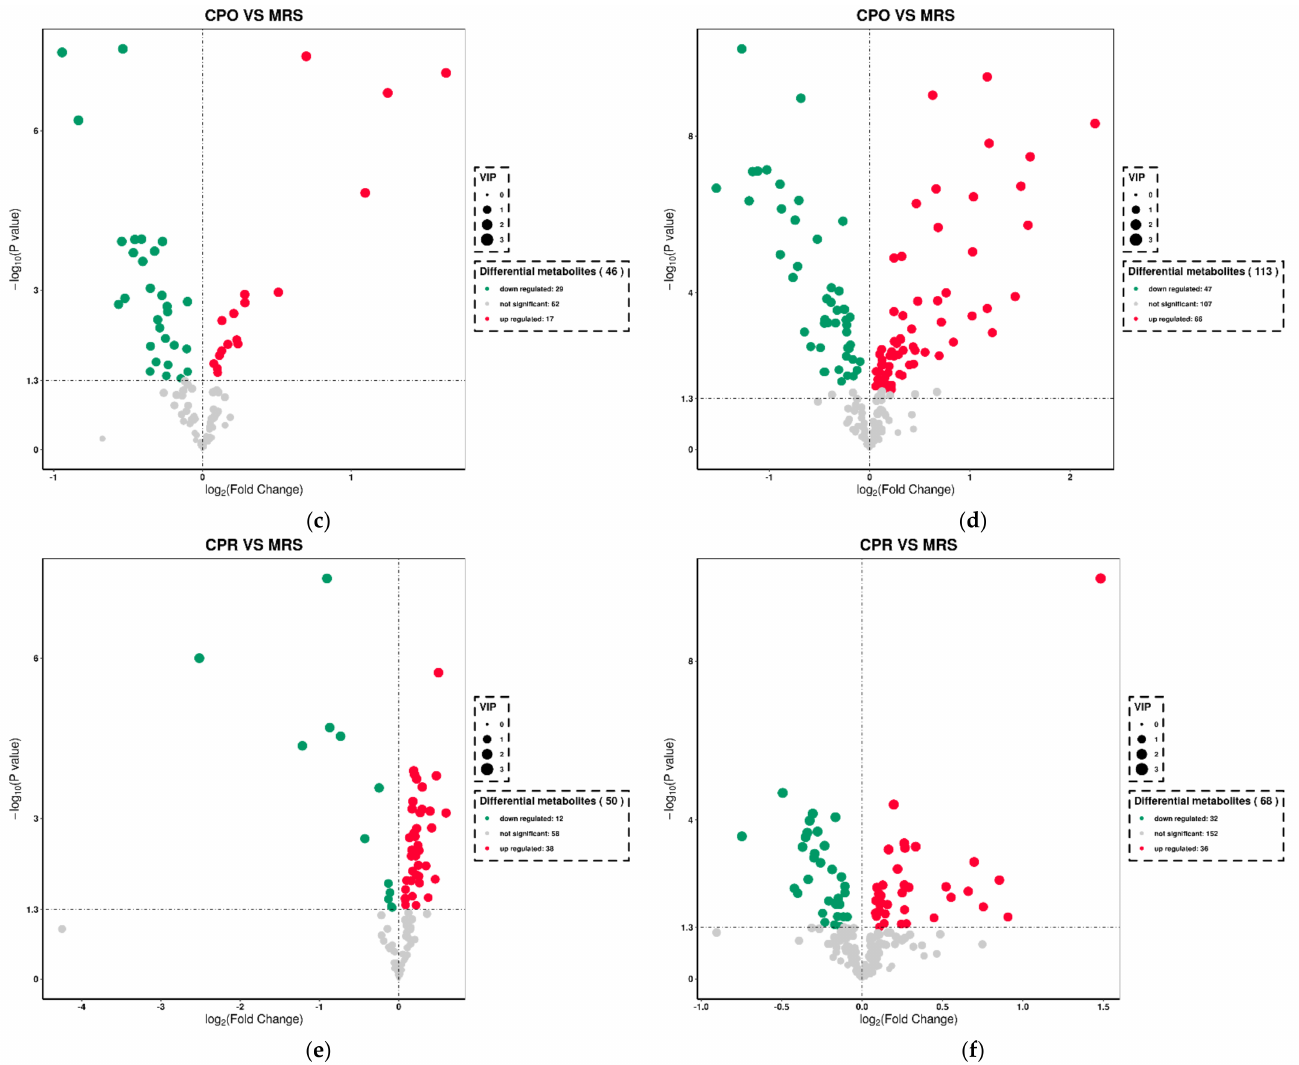
Figure 7. Volcanic plot of differential metabolites of L. reuteri in the medium supplemented with CSE under positive ion mode and negative ion mode. Positive ion mode: ( a ) (CSO vs. MRS), ( c ) (CPO vs. MRS), ( e ) (CPR vs. MRS). Negative ion mode: ( b ) (CSO vs. MRS), ( d ) (CPO vs. MRS), ( f ) (CPR vs.